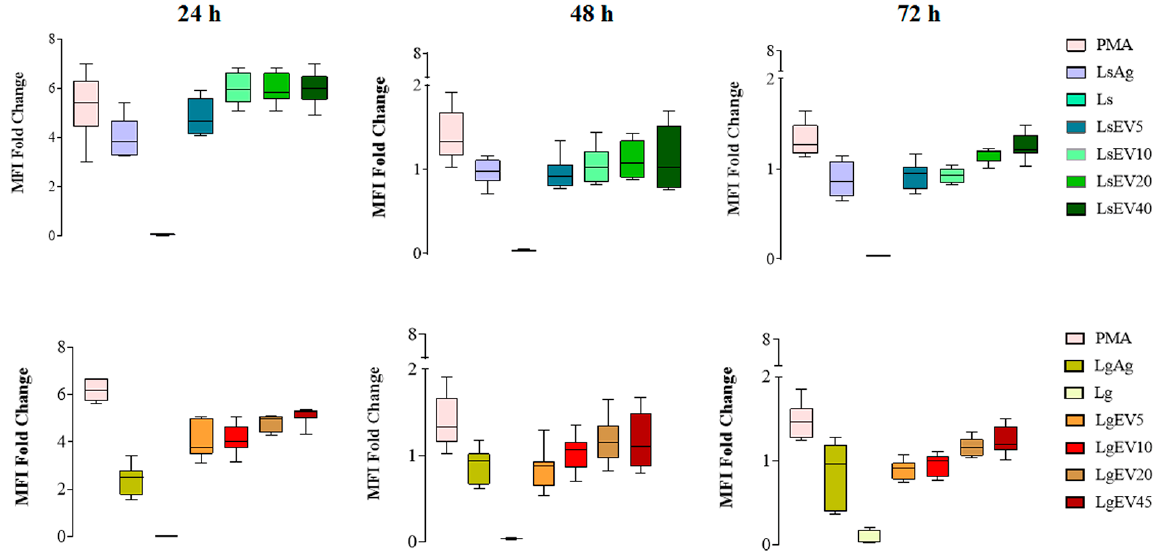
Figure 10. Effect of L. shawi and L. guyanensis EVs on density of MHCI molecules. M Φ incubated for 24 h, 48 h, and 72 h with 5 (LsEV5; LgEV5), 10 (LsEV10; LgEV10), 20 (LsEV20; LgEV20), and 45 µg·mL − 1 (LsEV45; LgEV45) of EVs shed by L. shawi and L. guyanensis , parasite antigens (Ag), and L. shawi (Ls) and L. guyanensis (Lg) promastigotes were analyzed by multiparametric flow cytometry. Fold changes in MHCI molecule density on M Φ are represented by the MFI (median fluorescence intensity) PMA—M Φ incubated with PMA as a positive control.